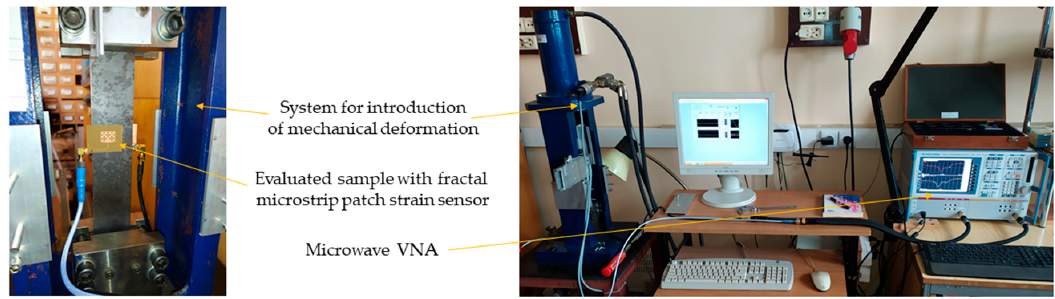
Figure 9. Photo of measuring system setup.